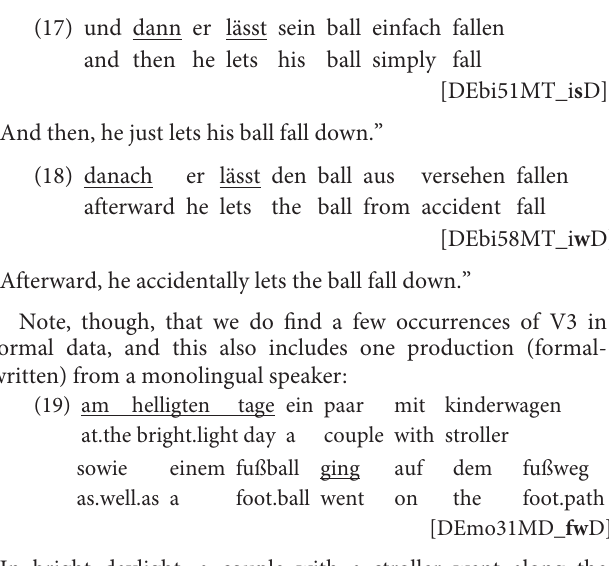
Frontiers in Psychology |